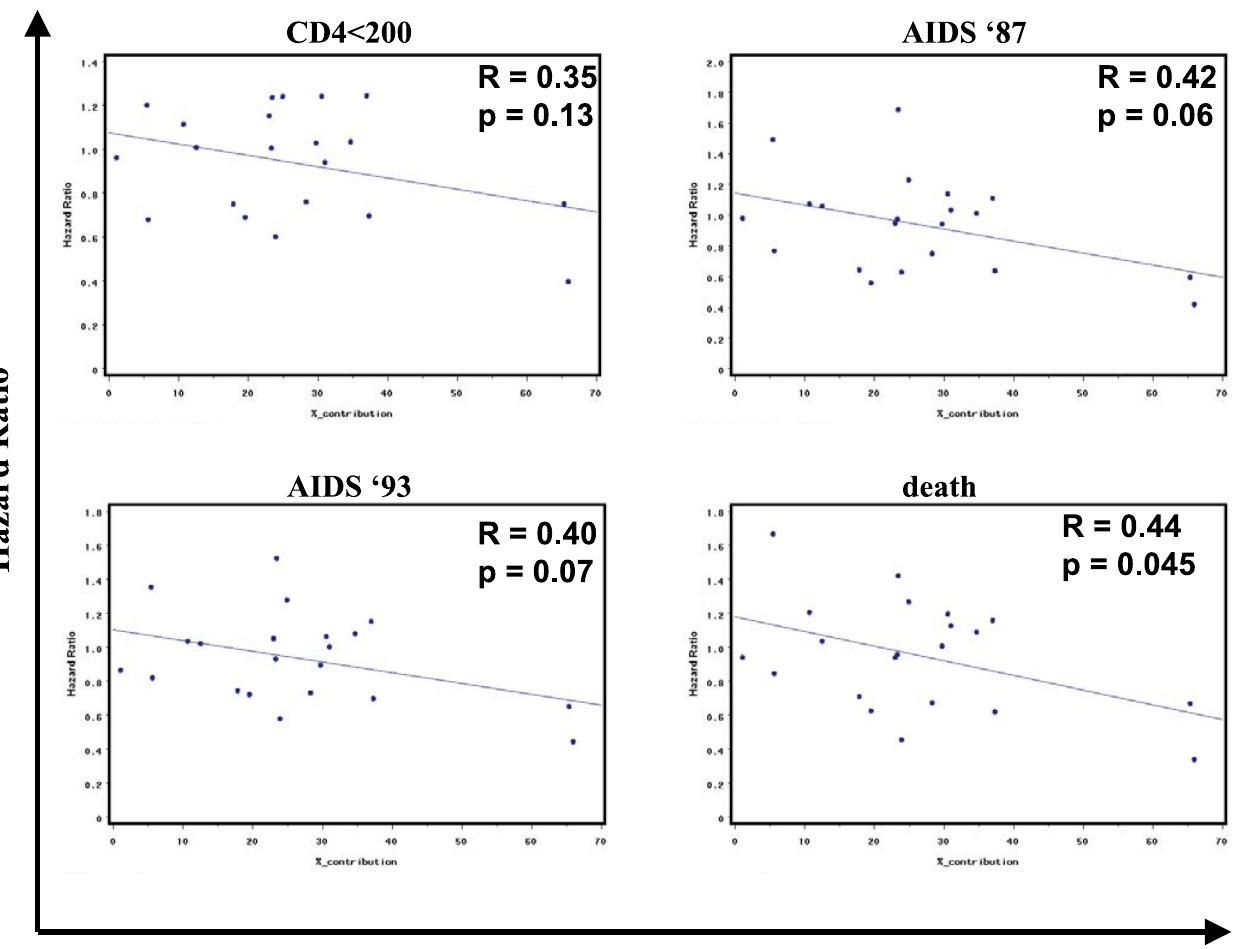
Figure 5. Correlation between the Contribution of Individual HLA Class I Alleles to the Total HIV-1-Specific CD8 þ T Cell Response during Primary Infection and the HR for HIV-1 Infection Outcome The percent contribution of individual HLA class I alleles to the total HIV-1-specific CD8 þ T cell response during primary infection was correlated to the HR for four different HIV-1 infection outcomes (time to CD4 , 200, time to AIDS 1987, time to AIDS 1993, and time to death) for the respective HLA alleles. DOI: